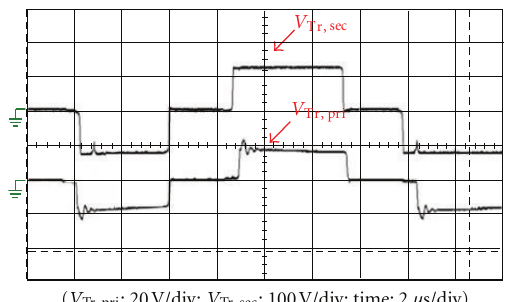
Figure 14: Measured primary and secondary voltage waveforms of the transformer.